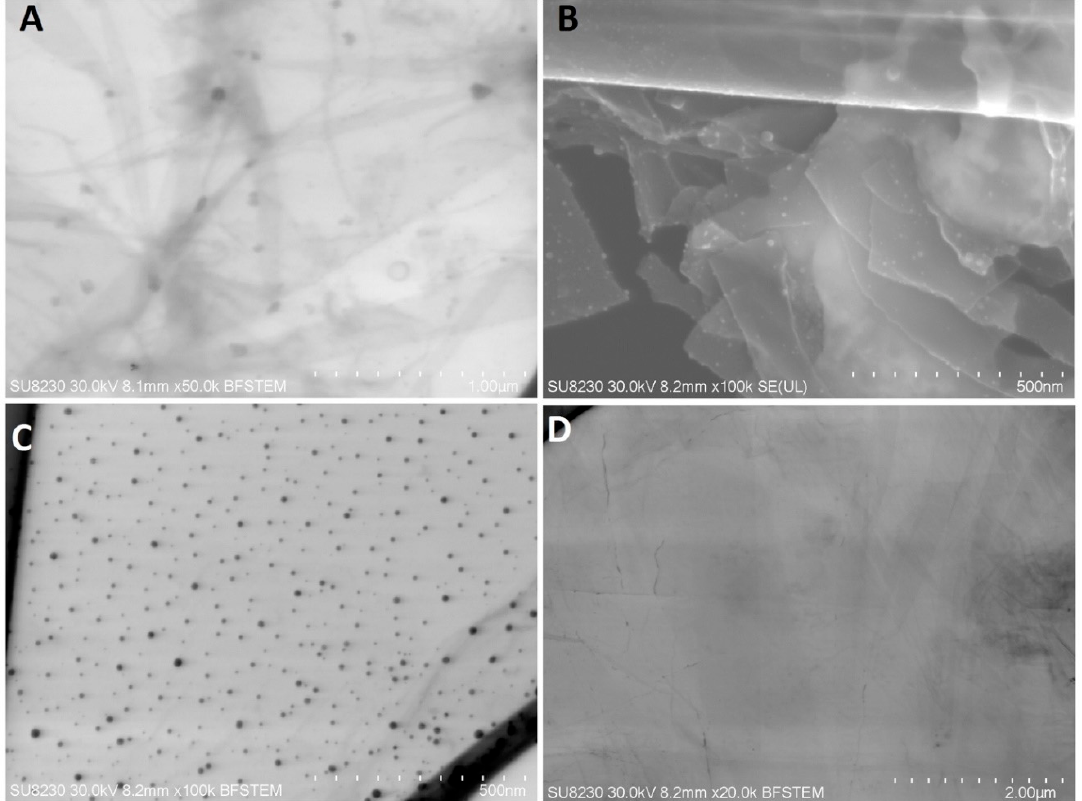
Figure 1. Scanning transmission electron microscopy images of ( A,B ) nanocomplexes of graphene oxide and platinum nanoparticles, ( C ) platinum nanoparticles, and ( D ) graphene oxide. Scale bars: bars: 500 nm–2 µ m. Abbreviations: GO-NP-Pt—nanocomplexes of graphene oxide and platinum 500 nm – 2 μ m. Abbreviations: GO-NP-Pt — nanocomplexes of graphene oxide and platinum nanoparticles, NP-Pt—platinum nanoparticles, GO—graphene nanoparticles, NP-Pt — platinum nanoparticles, GO — graphene oxide.